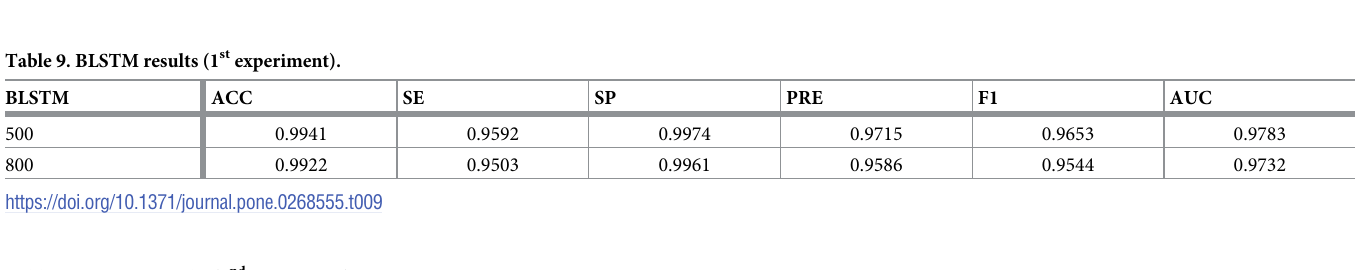
Table 10. BLSTM results (2 nd experiment).